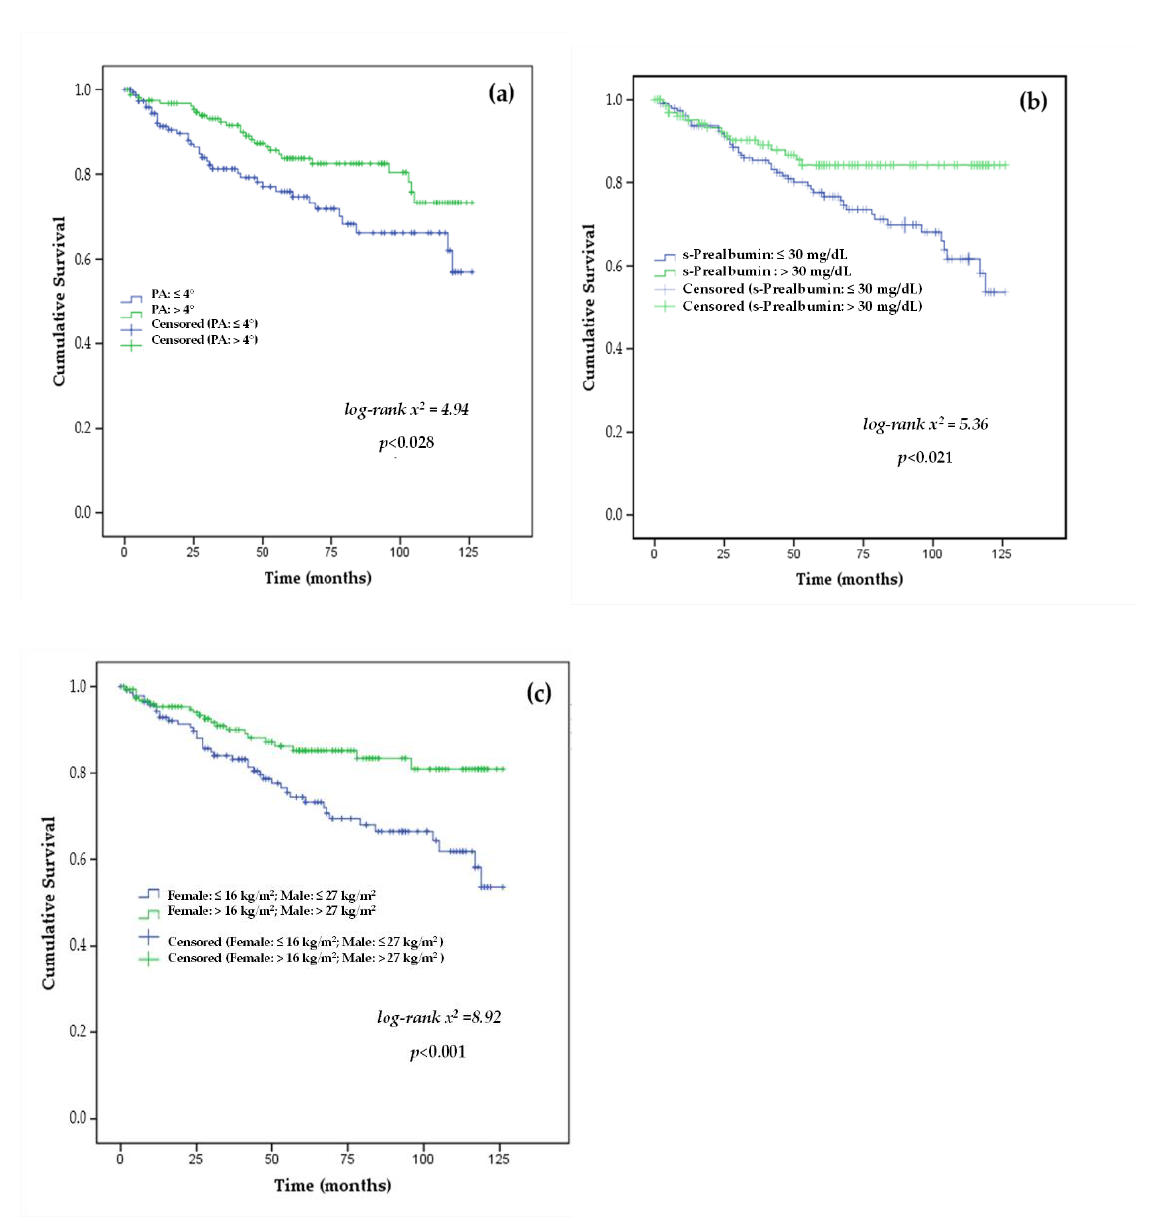
Figure 2. Kaplan – Meier survival curves of the study participants stratified by the cut-off-points of ( a ) a ge (≤72 vs. >72 years) and ( b ) malnutrition- inflammation score (MIS: ≤5 vs. >5 points) as mor- tality risk predictors in stage 3b, 4 – 5 chronic kidney disease patients.